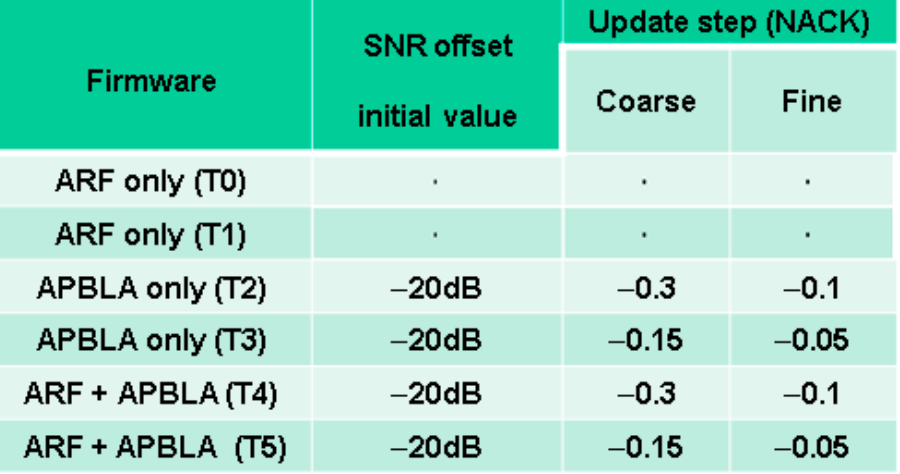
Figure 22. Firmware and parameters used for the wireless tests.